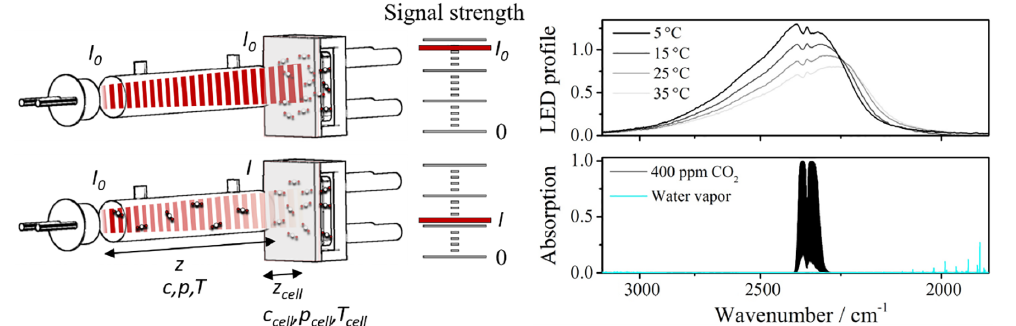
Figure 2. A schematic drawing of the basic setup of NDIR devices, which consist of a light source, an optical path enabling the interaction between light and gas molecules and a light detector to gauge the intensity. In case of no absorption the detected light intensity is at maximum. Absorption consequently leads to a decrease in detected light intensity in accordance with the Beer–Lambert law. The LED emission profile is sensitive to variations in temperature. The emitted intensity decreases with increasing temperature and the LED profile also shifts in position and width. In the top panel on the right, the LED profile in the range between 5 and 35 ◦ C relative to the normalized signal at 20 ◦ C is shown. In the right bottom panel, the spectral lines of CO 2 and H 2 O are shown for an optical path of 36mm for a concentration of 400ppm CO 2 and 70% rel. humidity at 30 ◦ C,